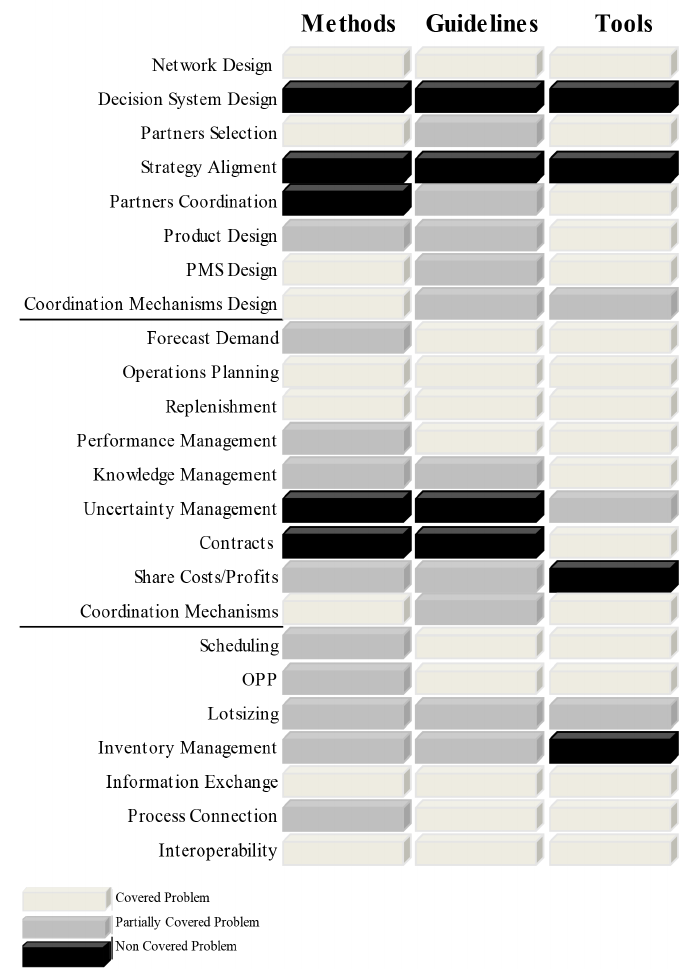
Figure 4. Building blocks for NHN Collaborative Framework. Problems with less satisfactory solutions in NHN